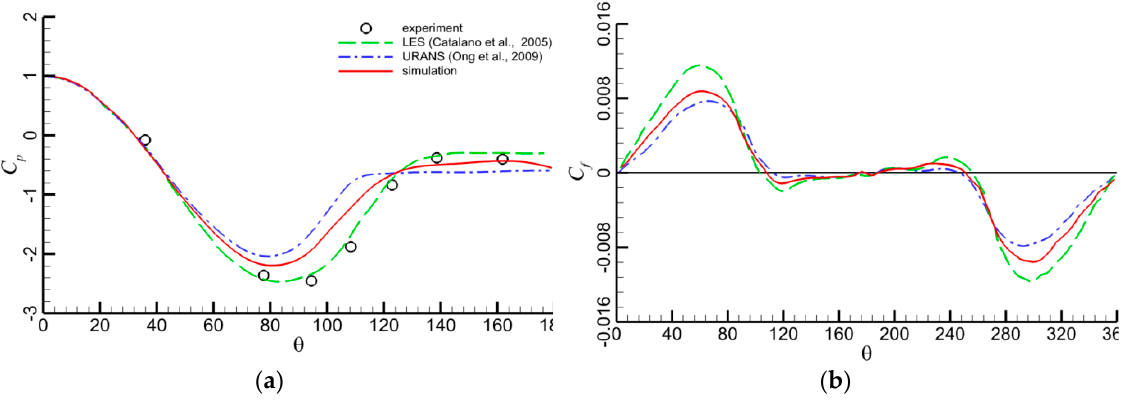
Figure 7. Comparison between simulation results and measurement data. ( a ) Mean pressure distribution. ( b ) Skin friction distribution.